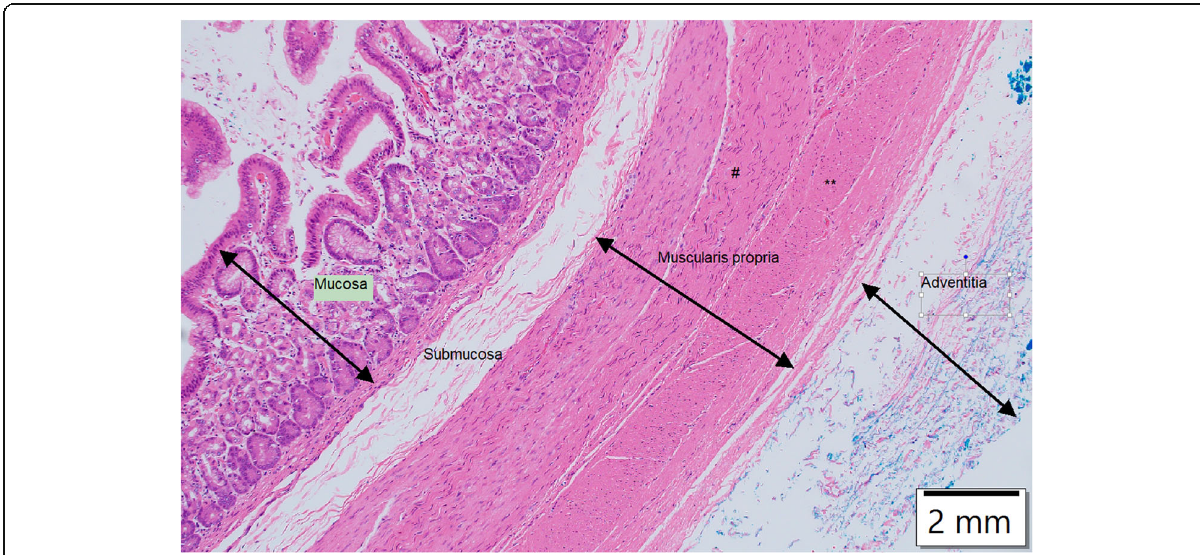
Fig. 3 Hematoxylin and eosin (H&E) stained section of cyst wall showing all four stomach layers including; lining of specialized gastric mucosa, submucosa, muscularis propria (both inner circular # and outer longitudinal**) and adventitia [×